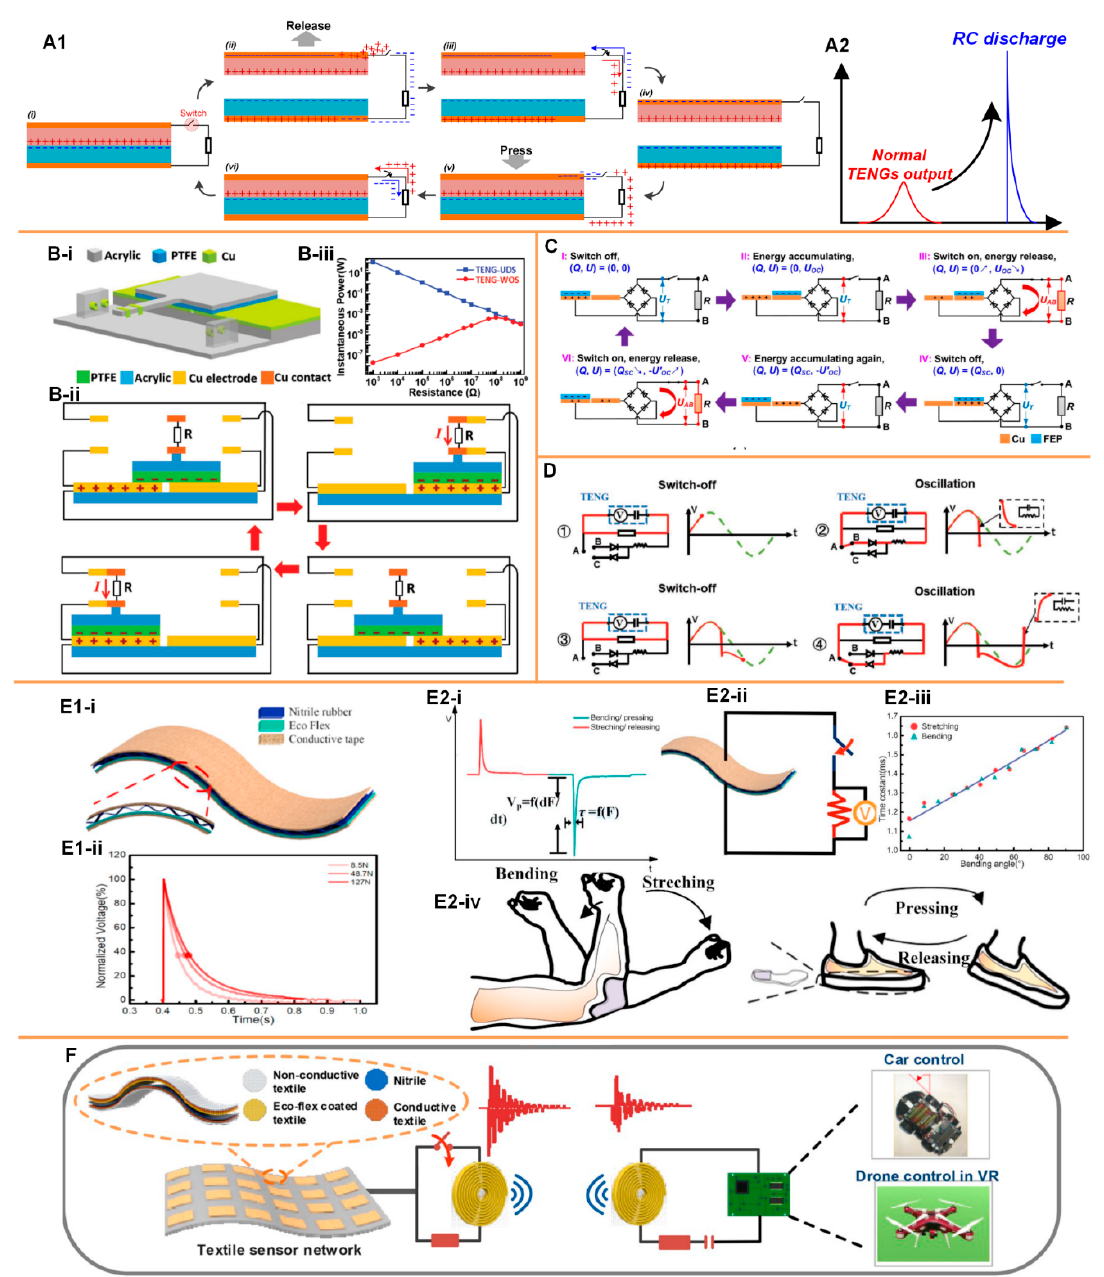
Figure 5. The TENG device integrated with the switching operation. ( A1 ) The working mechanism of the TENG device with switching operation; ( A2 ) The switching operation can convert the current waveform to an exponential wave (RC discharge); ( B ) A mechanical structure to realize the switching operation automatically during the operation. Reproduced with permission from [65]. Copyright 2018 WILEY-VCH Verlag GmbH & Co. KGaA, Weinheim; ( C , D ) Power management methods based on the switchable TENG devices, ( C ) reproduced with permission from [69] and copyright 2017 Elsevier, and ( D ) reproduced with permission from [70] and copyright 2019 WILEY-VCH Verlag GmbH & Co. KGaA, Weinheim; ( E1 , E2 ) Soft thin-film switchable TENG device used for physical sensing: ( E1 ) The layer structure of the soft thin-film switchable TENG device ( i ) and its typical output waveform by applying difference forces ( ii ); ( E2 ) The application for the physical sensing: ( i ) The physical operations can be decoded from the polarity (positive polarity refers to stretching/releasing and negative polarity refers to bending/pressing) and time constant (bending angle/force); ( ii ) The circuit configuration for the physical sensing; ( iii ) The bending angle decoded from the measured time constant; ( iv ) The application of bending angle and stepping force sensing when the TENG device is attached to the elbow and shoes; Reproduced with permission from [71]. Copyright 2020 Elsevier; ( F )